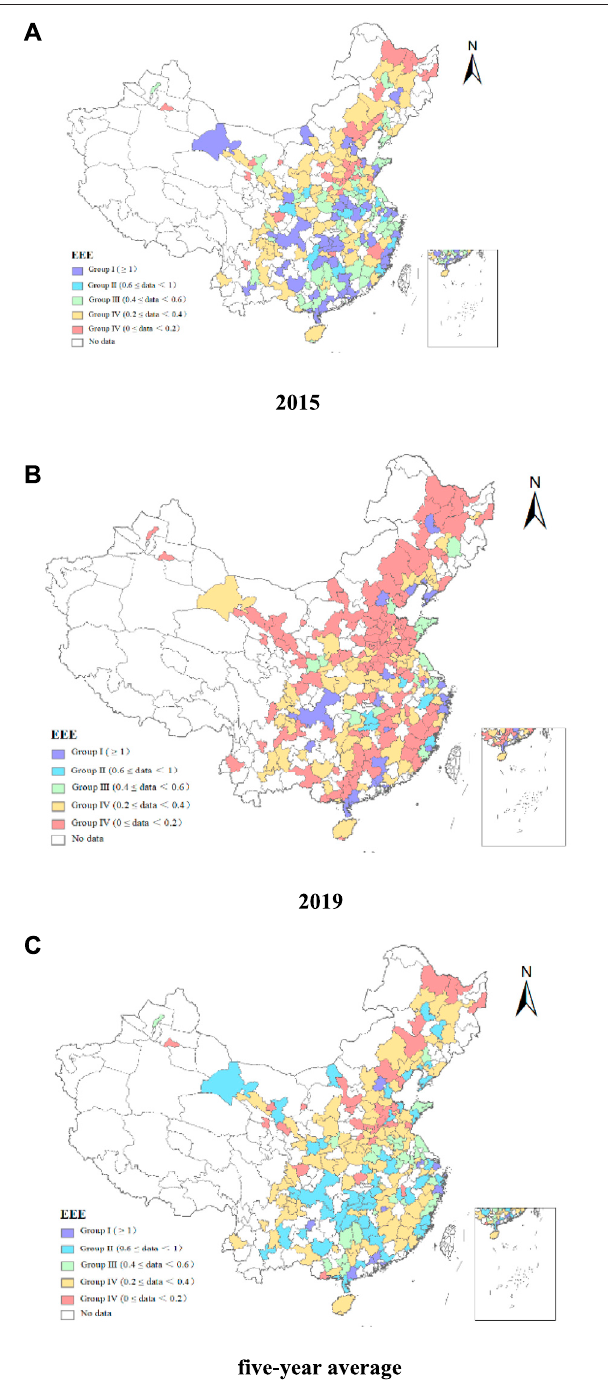
FIGURE 8 | Regional differences of the EEE from 2015-2019 (Subgraph a is the 2015 transportation system EEE value, subgraph b is the 2019 transportation system EEE value, and subgraph c is the fi ve-year average transportation system EEE value).